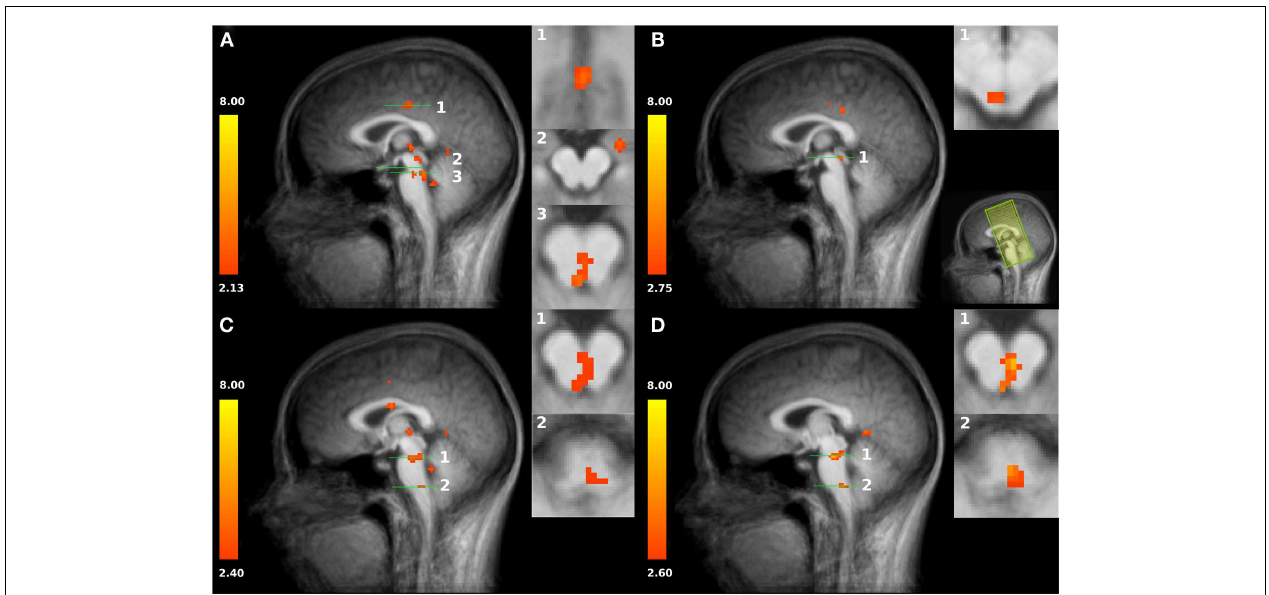
SSH compared to baseline in inferior part of the PAG, NRD (slice plane 1), and RVM (slice plane 2). (D) Increased activation to steep SSH compared to shallow SSH in PAG, NRD (slice plane 1), and RVM (slice plane 2). Statistical parametric maps are overlaid on aT1 scan (neurological convention, left =